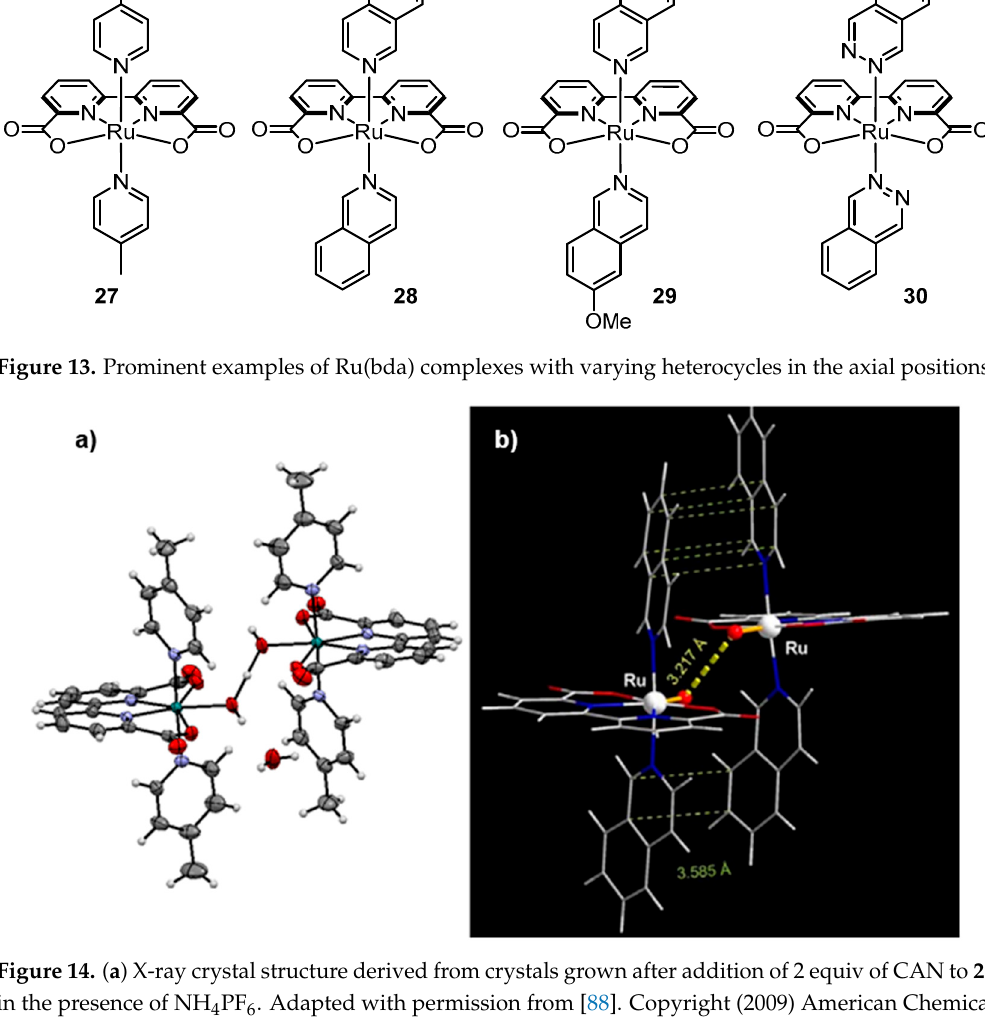
Figure 14. ( a ) X-ray crystal structure derived from crystals grown after addition of 2 equiv of CAN to 29 in the presence of NH 4 PF 6 . Adapted with permission from [88]. Copyright (2009) American Chemical Society. ( b ) Calculated “encounter complex” of two Ru V = O molecules with π -stacking interactions between the four isoquinoline units. Reprinted by permission from Springer Nature: Nature Publishing Group, Nature Chemistry, A molecular ruthenium catalyst with water-oxidation activity comparable to that of photosystem II, L. Duan, F. Bozoglian, S. Mandal, B. Stewart, T. Privalov, A. Llobet, L.